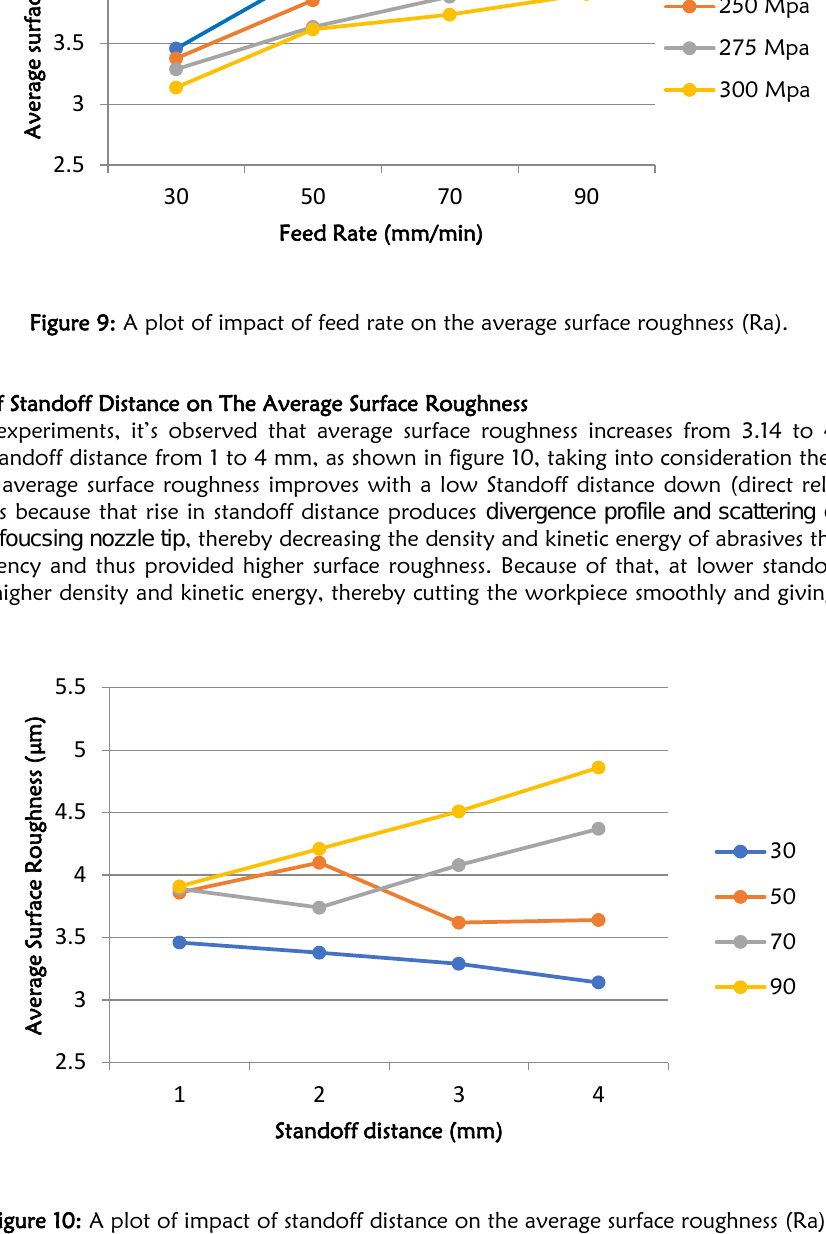
Figure 10: A plot of impact of standoff distance on the average surface roughness